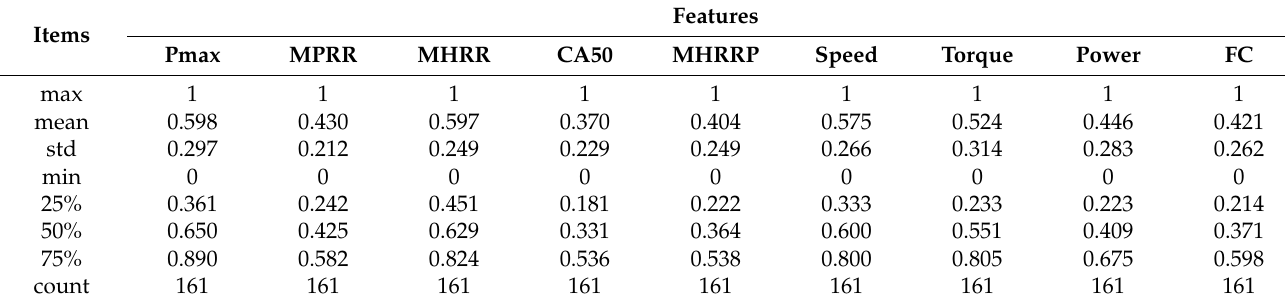
Table 4 lists the information of the normalized features. Table 4. Data information after normalization.